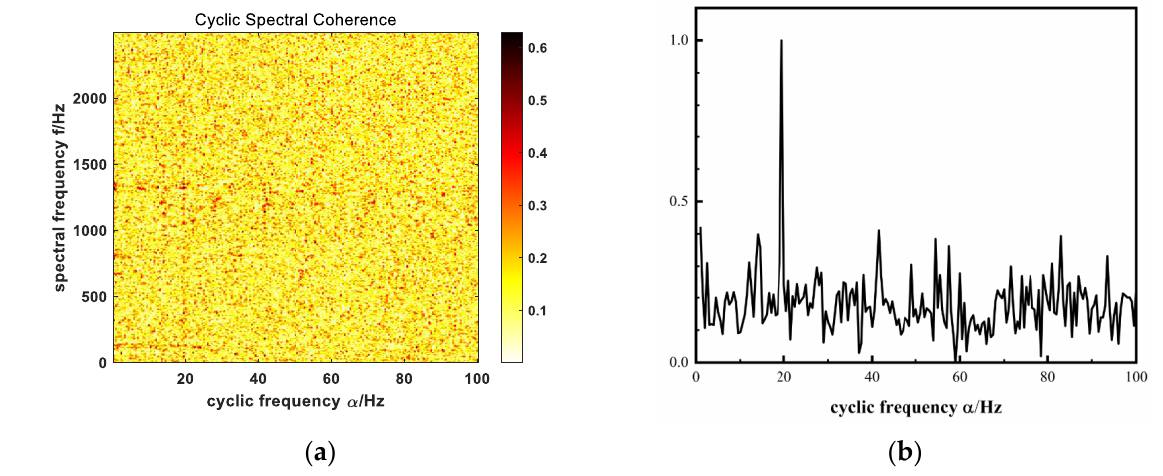
Figure 10. ( a ) The cyclic spectrum coherence function graph of the Robinson R44 helicopter at